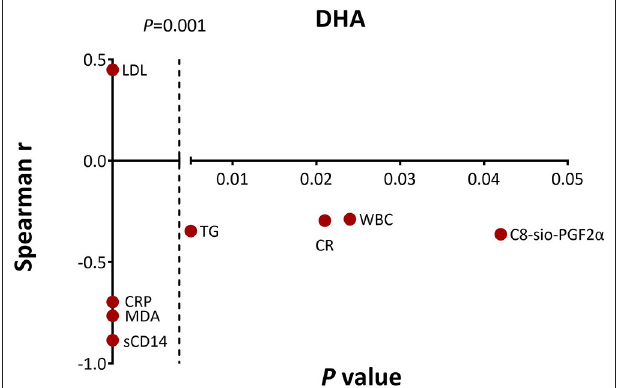
FIGURE 2 | Significant associations between change in docosahexanoic acid (DHA) level and changes in clinical parameters, proinflammatory and oxidative stress markers as measured by the Spearman’s correlations. CR,